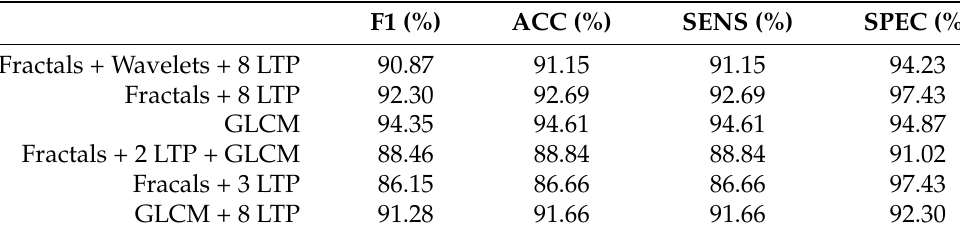
Table 8. Experiment 2—Final results using various performances.